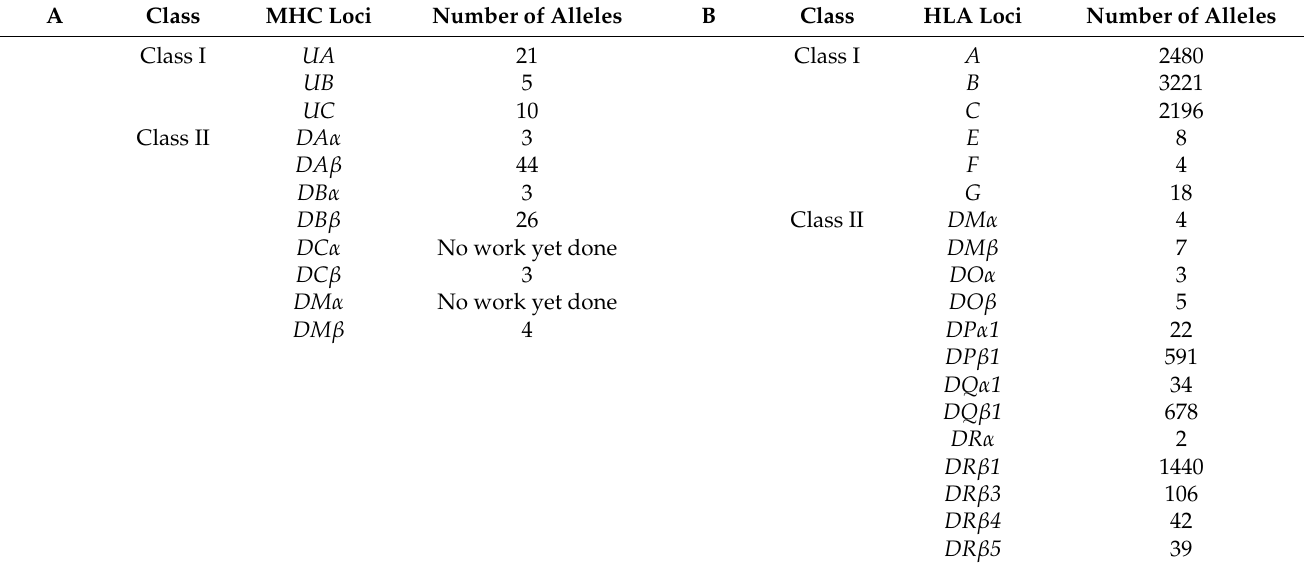
Table 1. Major Histocompatibility Complex (MHC)/Human Leukocyte Antigen (HLA) alleles currently recognised in koalas and humans, respectively. Part A—MHC alleles in koalas, Part B—HLA alleles in humans (from